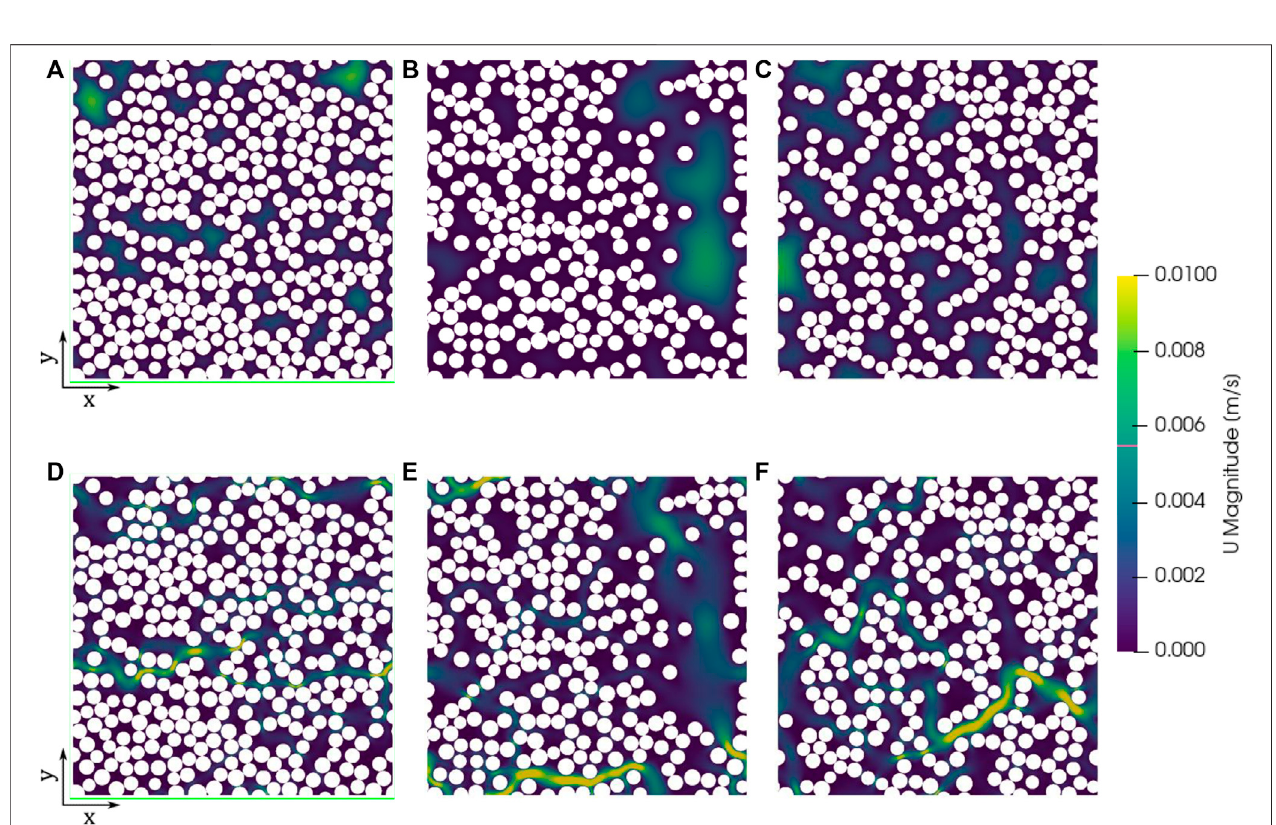
FIGURE 13 | Resin fl ow velocity of the three MVEs of Figure 2 with axial fl ow: (A) values corresponding to detail 1, (B) values corresponding to detail 2 and (C) values corresponding to detail 3; and the resin fl ow velocity with transverse fl ow in x-direction: (D) values corresponding to detail 1, (E) values corresponding to detail 2 and (F) values corresponding to detail